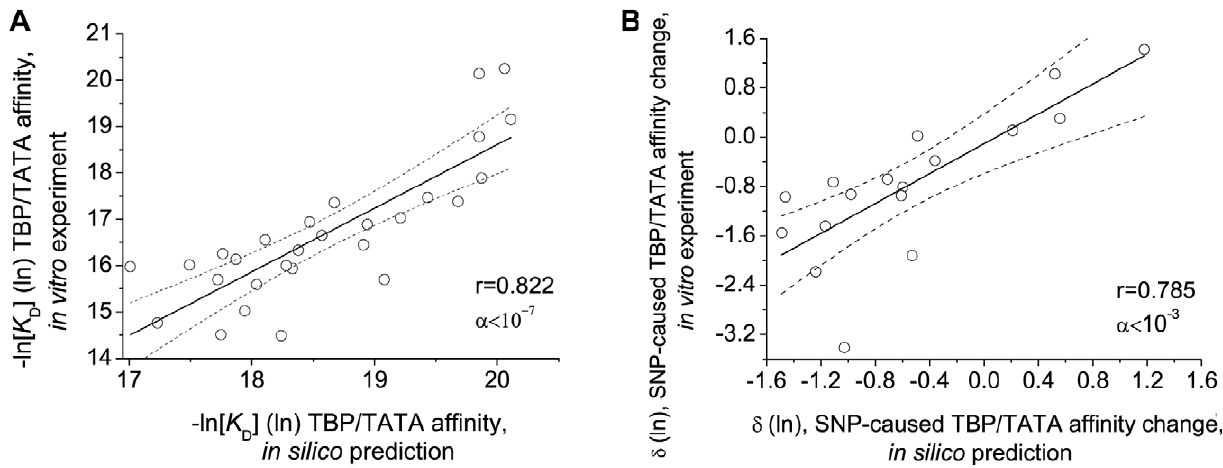
Figure 1. The experimentally measured affinity and affinity change are highly correlated with the predicted values. ( A ) The correlation between the TBP/TATA affinity as predicted in silico and measured in vitro. The coefficient of linear correlation, r, is 0.822 at a significance level of a , 10 2 7 . ( B ) The correlation between SNP-caused TBP/TATA affinity change ( d ) as predicted in silico and measured in vitro. The coefficient of linear correlation, r, is 0.785 at a significance level of a , 10 2 3 . 95% confidence intervals for linear regression built using the package STATISTICA.